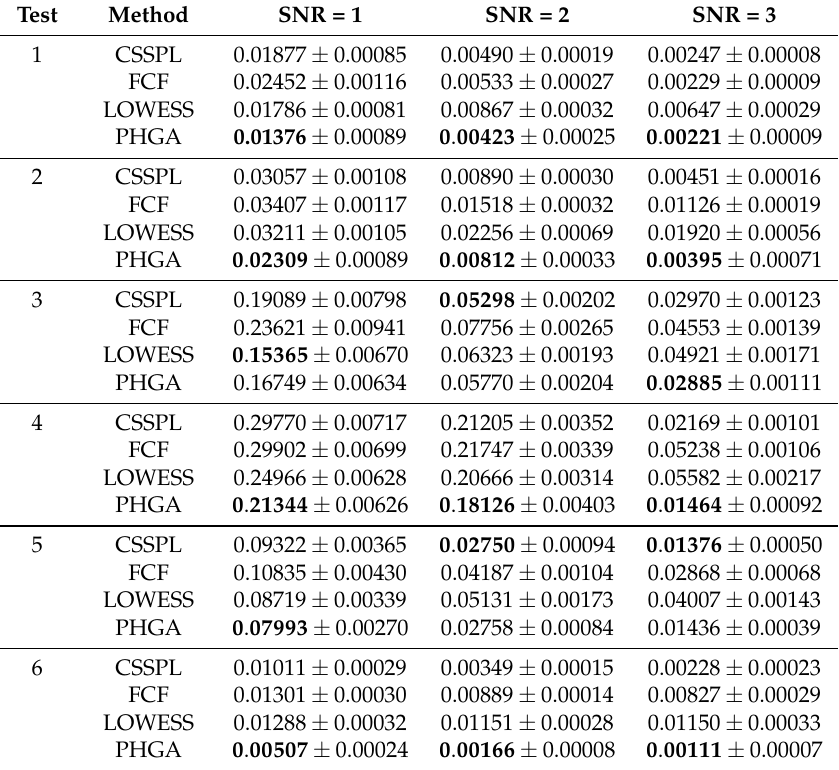
Table 4. Mean of the computed mean square errors (MSEs) with estimated standard errors based on 100 test sets with 100